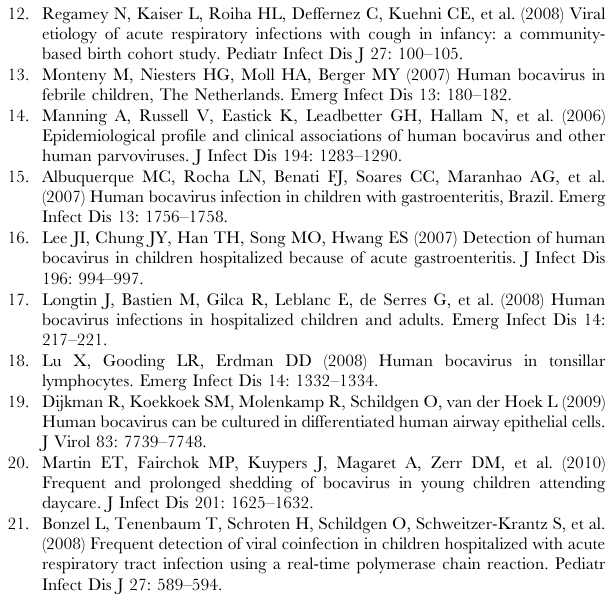
Table S1 Primers and probes used in conventional and real-time